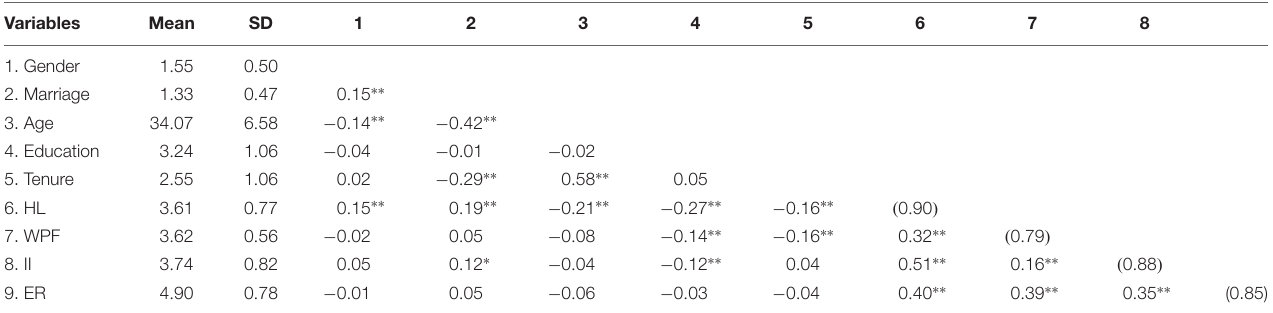
TABLE 2 | Means, standard deviations, and correlations for the variables (study 1).